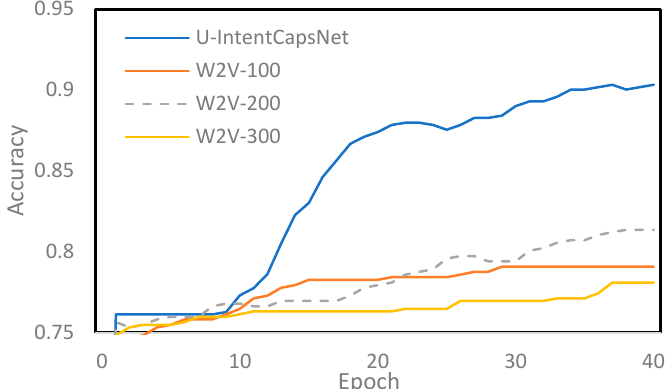
Figure 5. Learning curves of baseline models with pre-trained W2V embeddings and the proposed U-IntentCapsNet model in terms of accuracy.